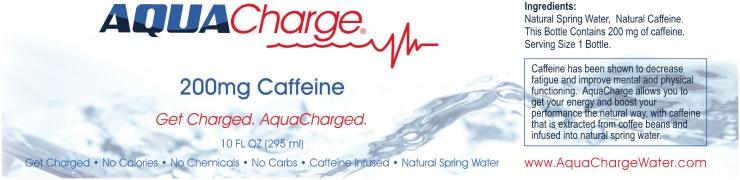
AquaCharge Energy Water label.The AquaCharge Energy Water label was designed specifically for the purposes of study by Gibbs Graphics. The label was printed and attached to 8oz plastic bottles of plain spring water containing no caffeine. This label is reprinted under a CC BY license, with permission from Gibbs Graphics, original copyright 2013.